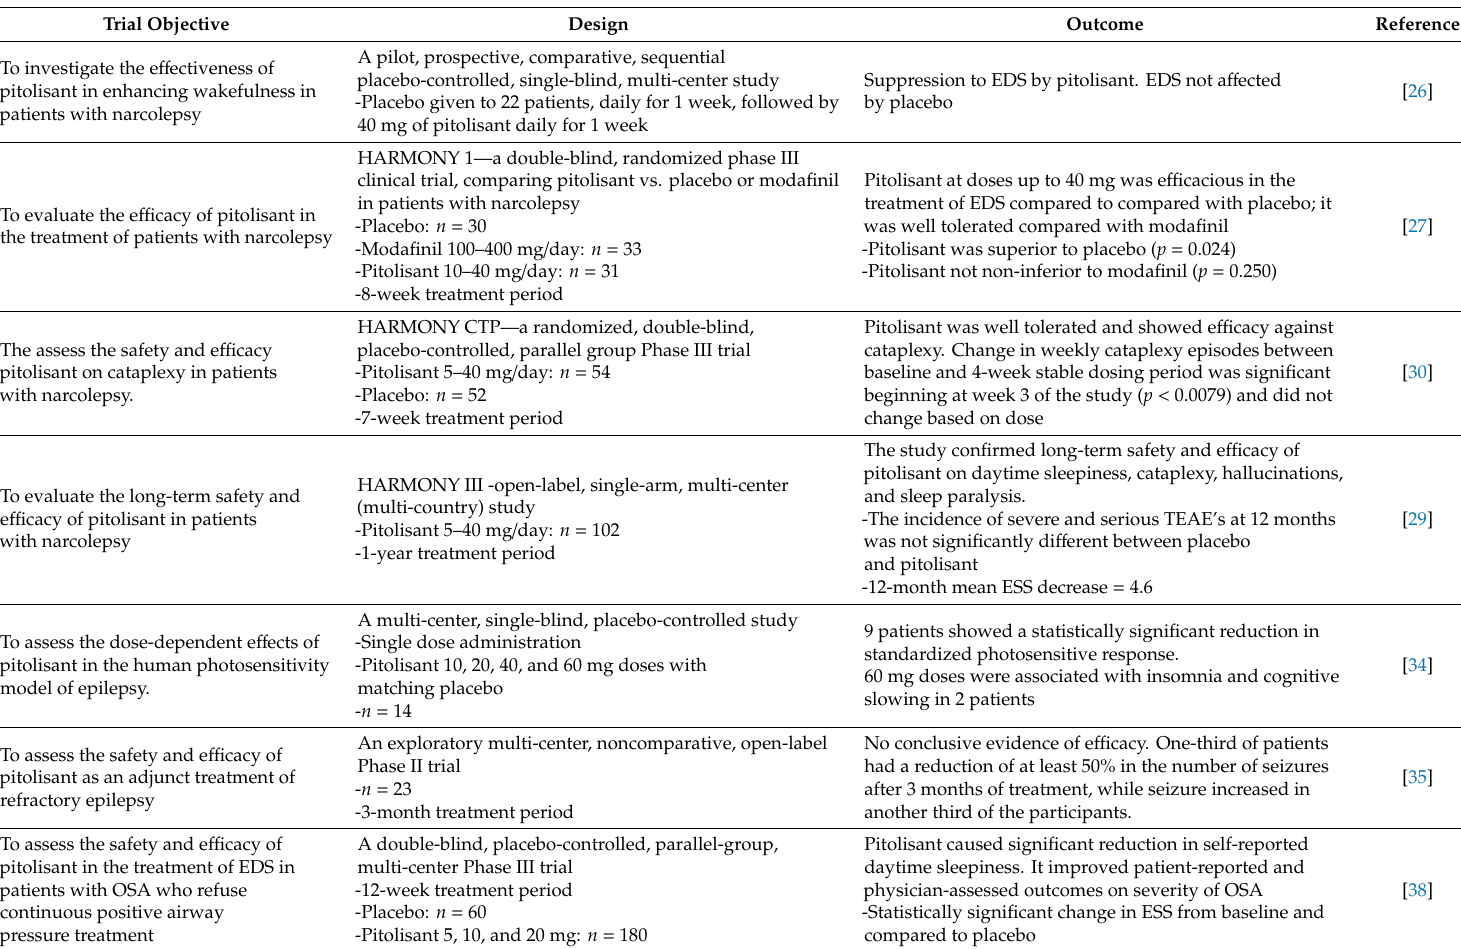
Table 2. Relevant studies in the clinical development of